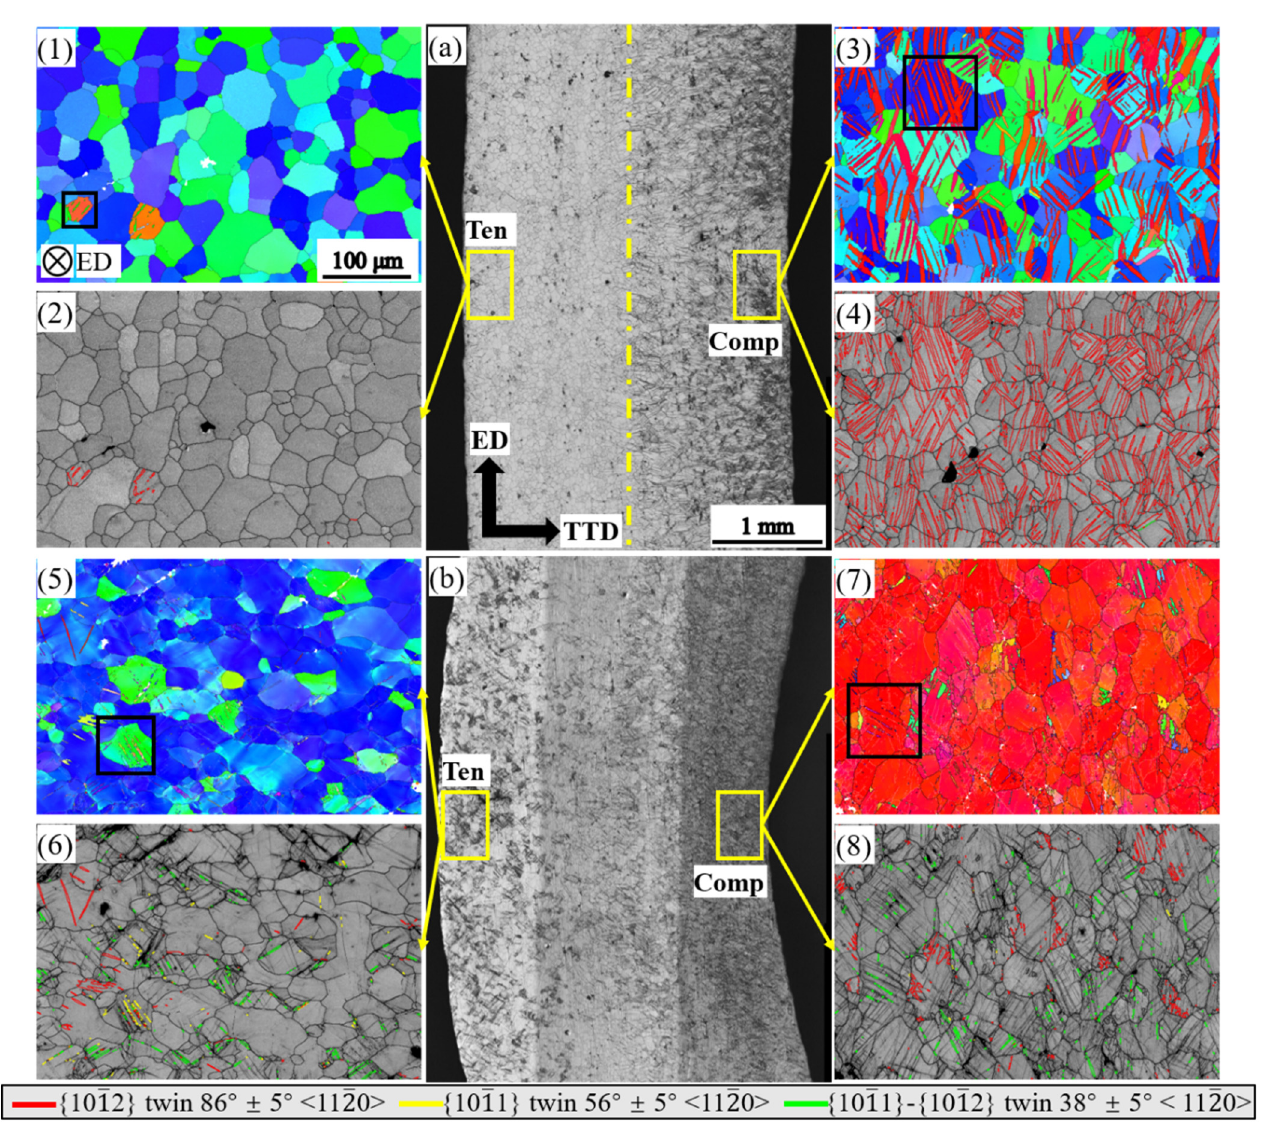
Figure 4. Microstructure of the ED bending bar at a bending displacement of 3 mm and at fracture: ( a , b ) optical micrograph of the bent sample; ( 1 , 3 , 5 , 7 ) inverse pole figures of the bent bar; ( 2 , 4 , 6 , 8 ) band contrast map of the bent bar with twinning boundary characterized.